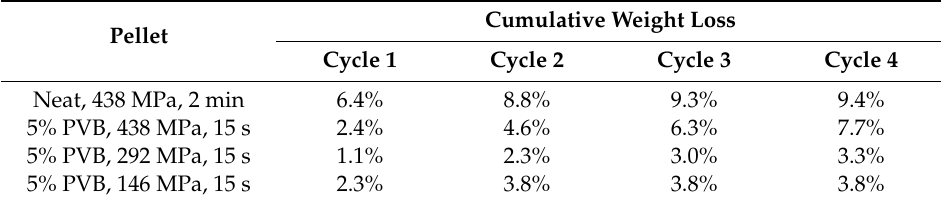
Table 1. Results of attrition tests for 16-mm diameter pellets.